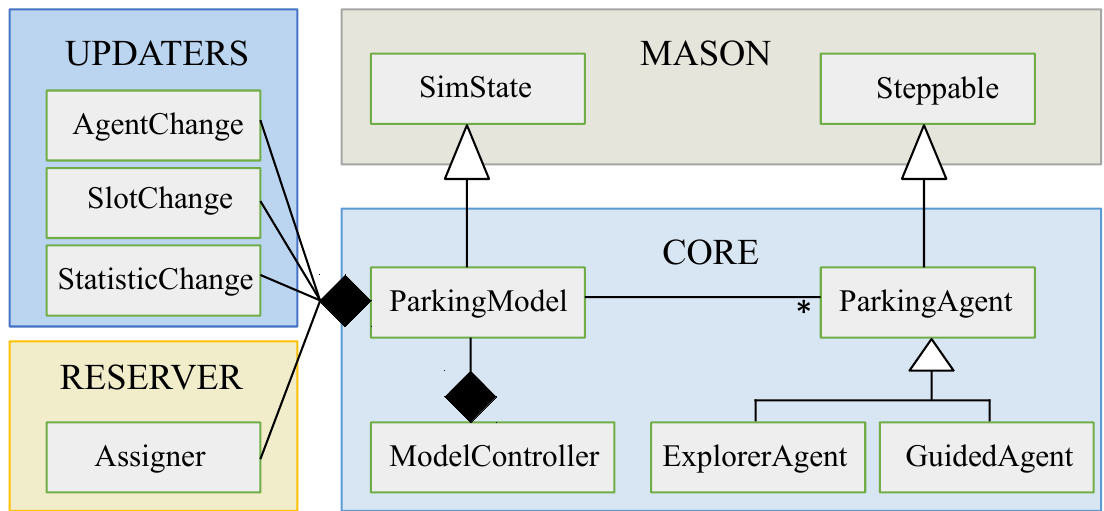
Figure 2. Main classes of the Model layer and their